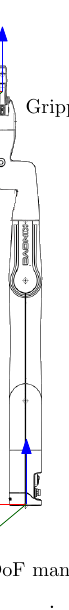
Figure 6. Frames in the experimental setup ( x -axis in red, y -axis in green, z -axis in